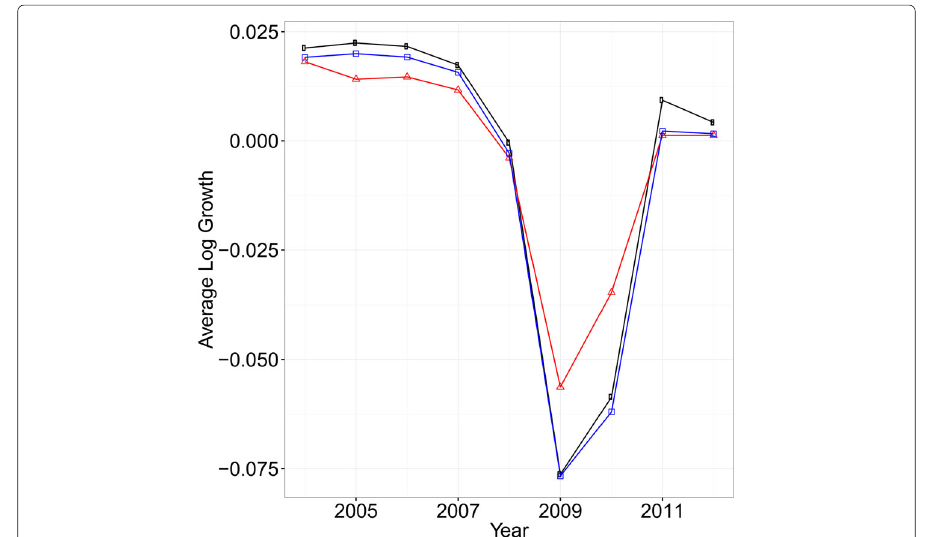
Fig. 6 Time series of average log growth rates ( blackcircles ), average shocks for individual firms ( redtriangles ) and simulated average log growth rate assuming that there was no link renewal ( bluesquare ) for years 2004 to